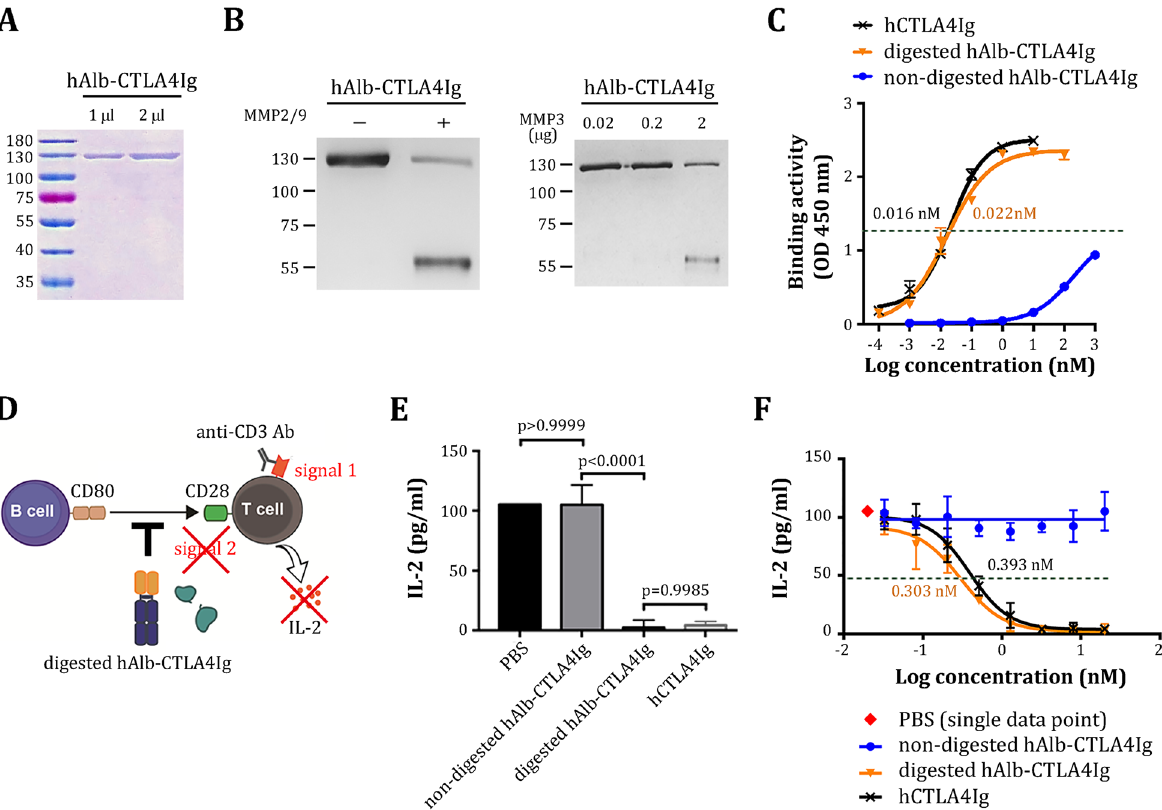
Fig. 4 Production, binding kinetics, and biological activity of hAlb‑CTLA4Ig. A Purity assessment of hAlb‑CTLA4Ig by SDS‑PAGE and Coomassie blue staining after purification of the recombinant proteins from the culture supernatant of ExpiCHO transfectants. B Cleavage of hAlb‑CTLA4Ig by MMP2/9 (left panel) and MMP‑3 (right panel) was assessed by western blot using a goat‑anti human IgG antibody. C Binding kinetics of nondigested hAlb‑CTLA4Ig (blue curve), MMP‑digested (orange curve) hAlb‑CTLA4Ig, or conventional hCTLA4Ig (black curve) were analyzed using cell‑based ELISA. EC 50 values are indicated with matching colors. D Schematic representation of the in vitro human T cell activation model in the current study. E Effects of nondigested hAlb‑CTLA4Ig, MMP‑digested hAlb‑CTLA4Ig, or conventional hCTLA4Ig (all at 1 nM) on IL‑2 secretion by Jurkat T cells. F Inhibition curves of Jurkat T cell activation by nondigested hAlb‑CTLA4Ig (blue curve), MMP‑digested hAlb‑CTLA4Ig (orange curve), or conventional hCTLA4Ig (black curve). IC 50 values are indicated by matching